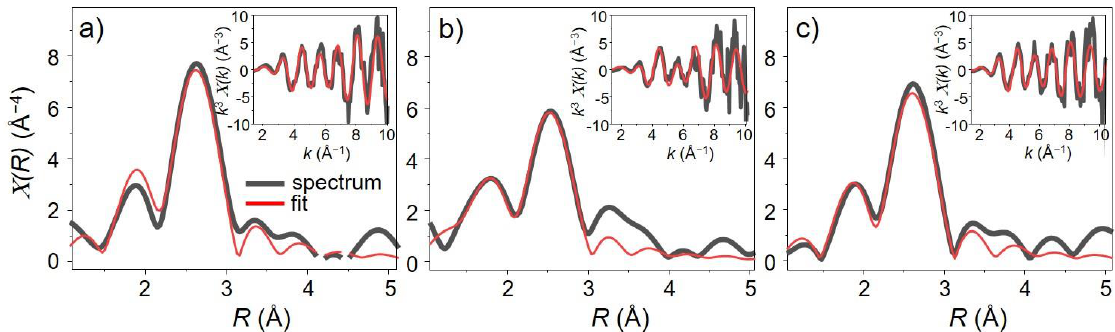
Figure 8. Fitting results (R-space and, insets, k-space) for the Pd k-edge EXAFS spectra of 2 wt.% Pd/Al 2 O 3 at 300 ◦ C ( a ) at the beginning of the O 2 pulse, ( b ) at the end of the O 2 pulse, and ( c ) at the end of the CO pulse. Black lines represent the experimental spectrum and red lines correspond to the fit. Table 1. Fit parameters for EXAFS spectra of 2 wt.% Pd/Al 2 O 3 acquired at 300 o C during CO and